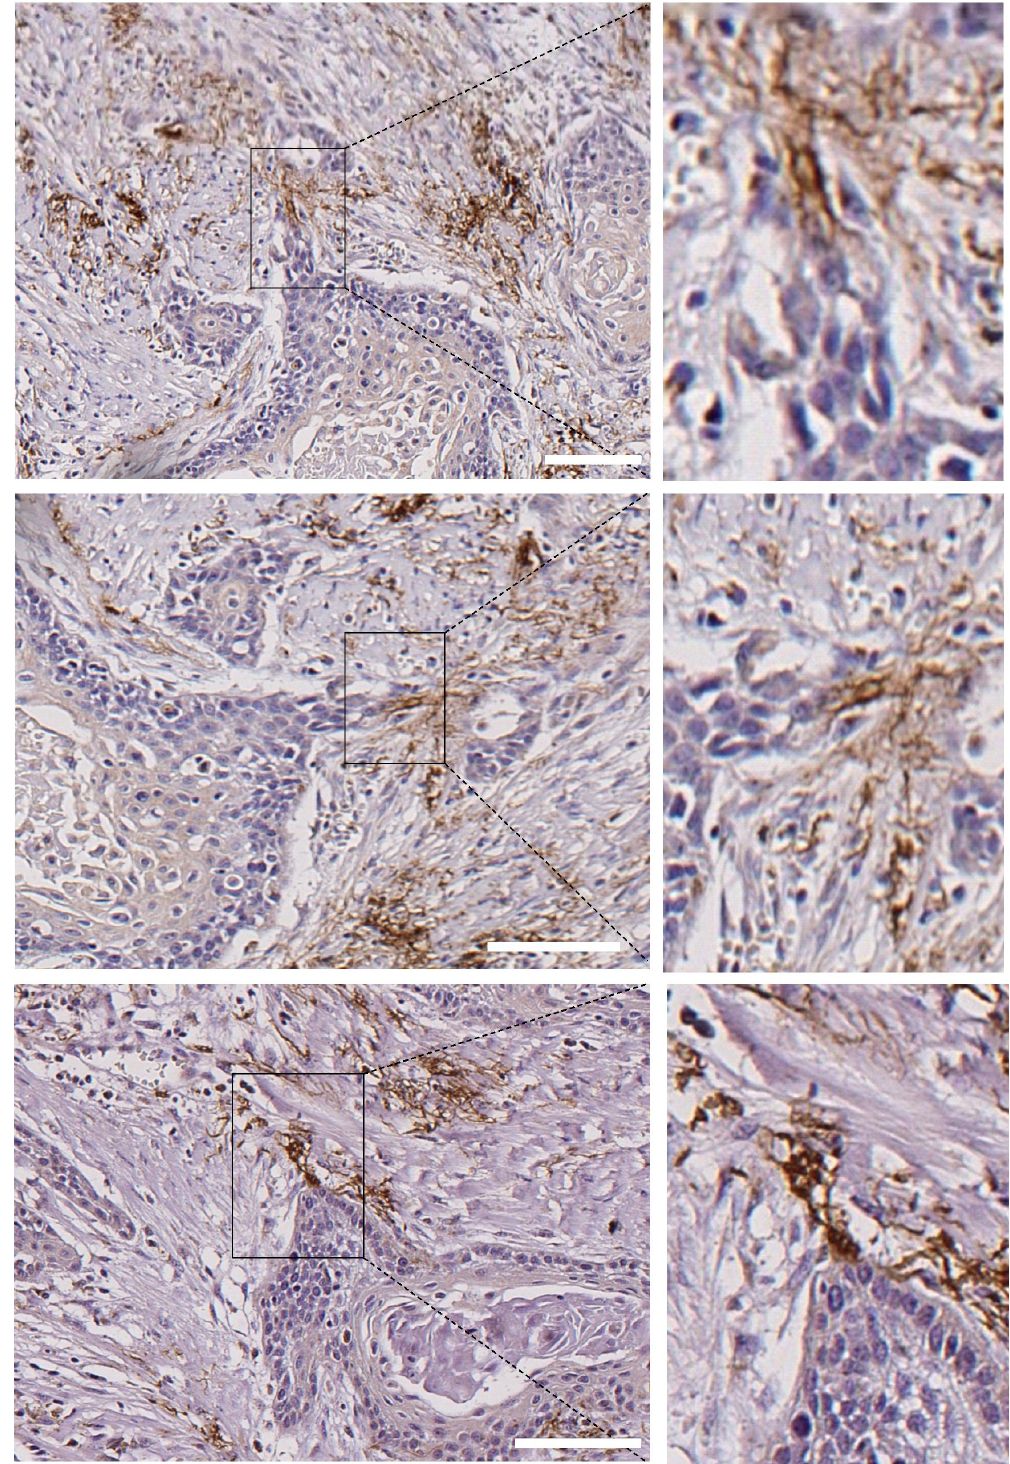
Figure 7. Presence of N-cadherin stromal cells in contact with the tips of tumor nests in human head and neck SCCs. Submitted as separate file to keep proper resolutions of images. Three different areas of a single head and neck SCC that contain tumor nests with invasive N- tumor cells that are connected with stromal N + cells at the tips of the invasive cell tracks. Higher magnifications of the areas outlined in the right pictures are shown in the left pictures. Scale bars: 100 μ m (upper and bottom images) and 50 μ m (image at the middle).